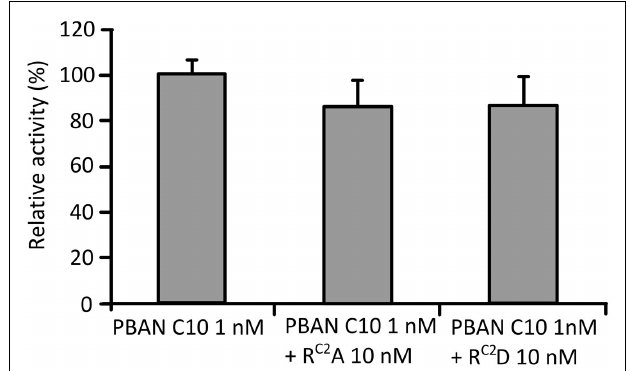
FIGURE 2 |Antagonistic effects of R C2 A and R C2 D. Effects were measured using the Ca 2 + imaging technique with Fura Red as the Ca 2 + indicator. PBAN C10 was added after the addition of R C2 A and R C2 D. Bars represent the mean + SD of five replicates.